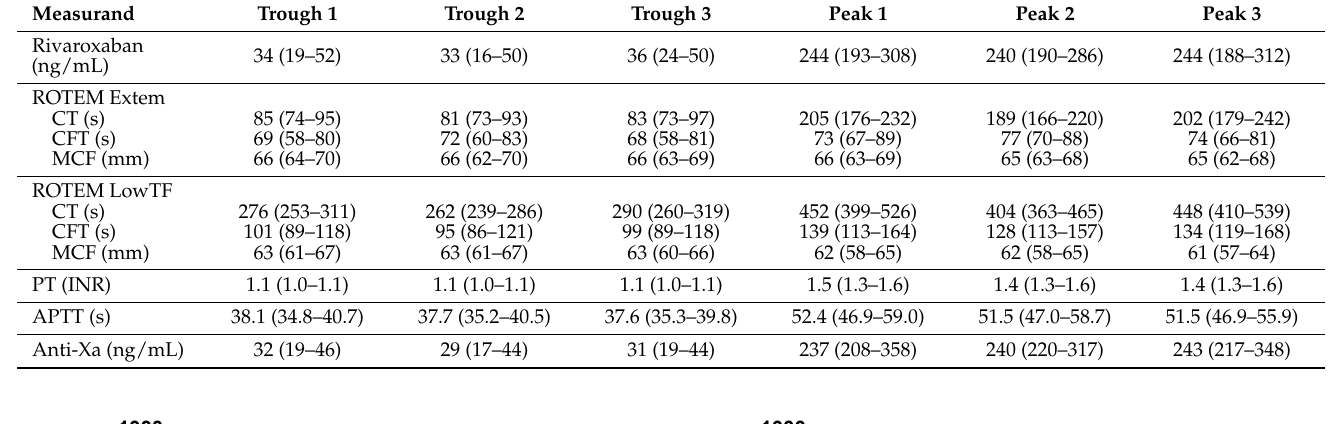
Table 2. Rivaroxaban concentration, ROTEM, PT, and APTT results at trough and at peak. Medians with first to third quartiles are shown.